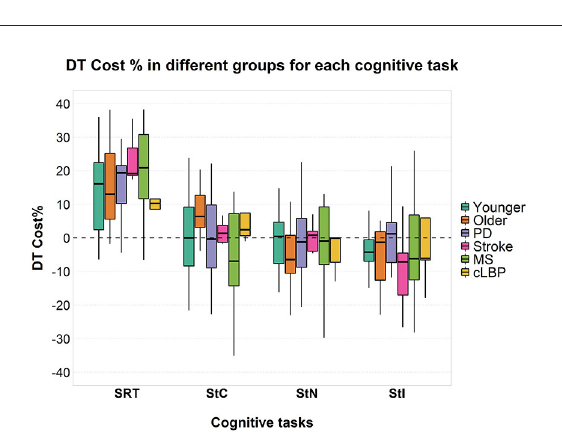
FIGURE4 Cognitive DTC across the different groups in each cognitive task. A negative value means a reduced response time and a consequently better performance and vice versa. A dashed line to mark the zero was added. SRT, Simple Reaction Time; StC, Congruent Stroop Test; StN, Neutral Stroop Test; StI, Incongruent Stroop Test.